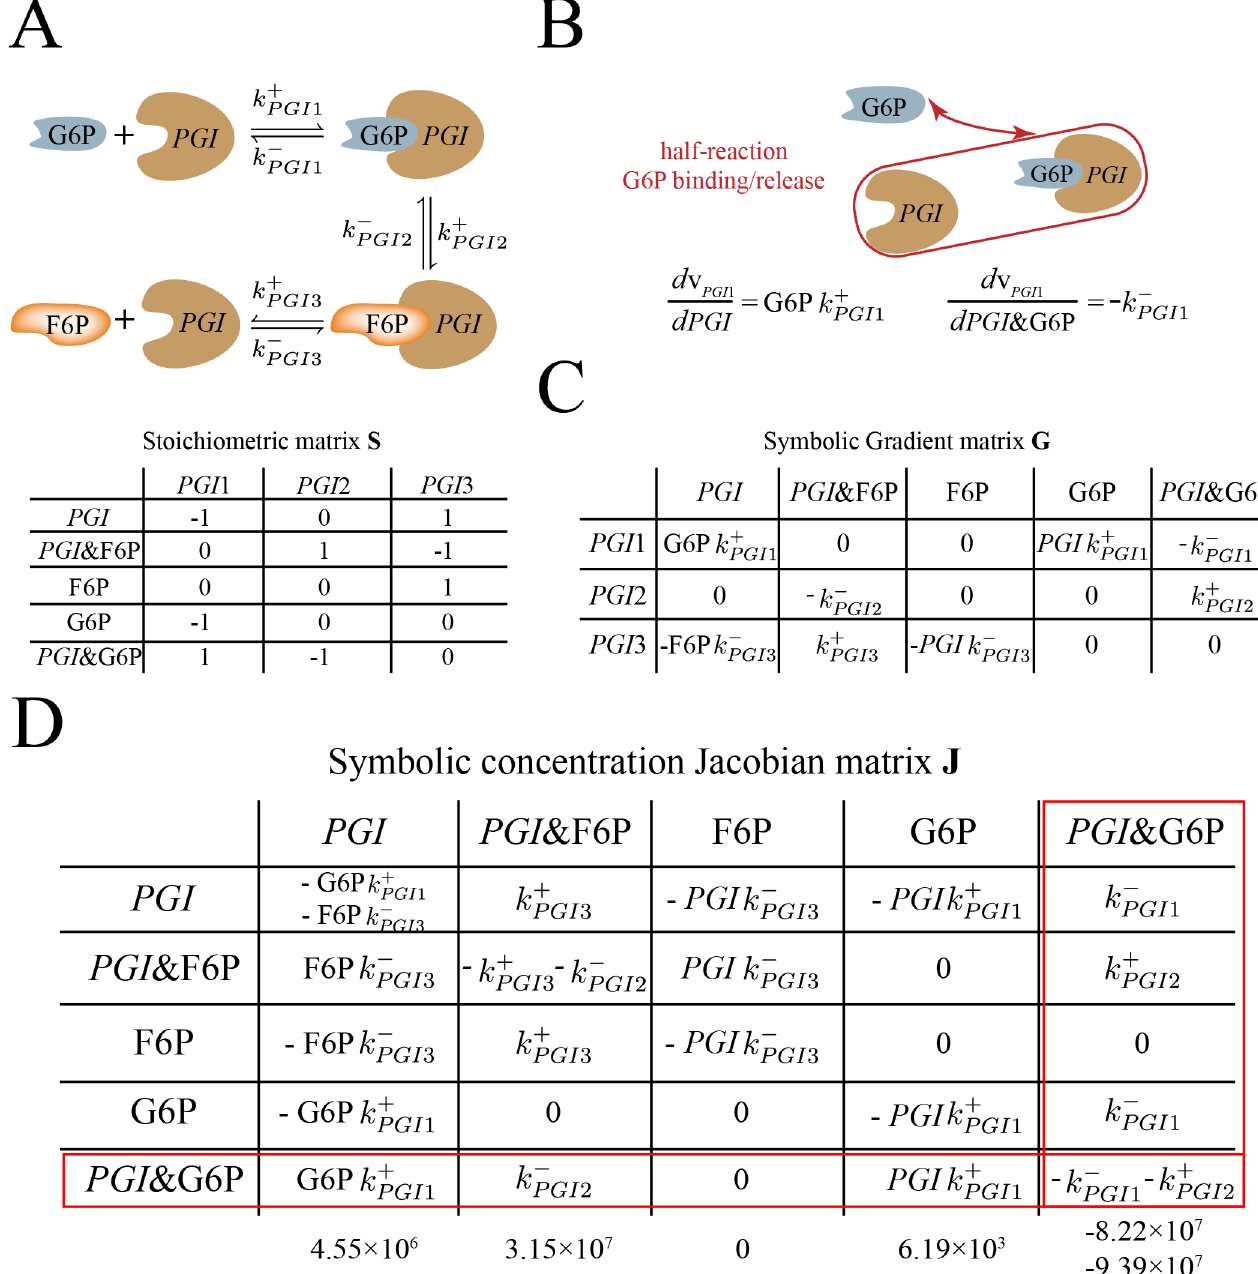
Fig 1. PGI enzyme module and its associatedmatrices. (A) A schematic diagram of individual reaction steps associatedwith PGI enzyme module and its stoichiometric matrix. The PGI enzyme module consists of three reactionsteps: bindingof G6P ( PGI 1), conversionof G6P to F6P ( PGI 2) and releaseof F6P ( PGI 3). The enzyme form PGI is in italic. We use an “&” notation to denote that the enzyme form is bound with metabolite (s). (B) Graphicalrepresentation of the concept of half reaction. Here we demonstrate the half reaction associatedwith the binding/release process of G6P, which is held constant. To determinethe equilibriumstate of this half reaction, we are comparing the sensitivitiesassociatedwith PGI (G6P k + PGI 1 ) and PGI &G6P (- k - PGI 1 ). This comparisonis equivalentto comparing G6P concentration and 1/K eq , PGI 1 . (C) The gradientmatrix of the PGI enzyme module.The gradientmatrix (= d v / d x )is obtainedfrom linearization of the reaction rates and representsreaction sensitivitiesto metaboliteconcentrations. (D) The cause of diagonaldominancedemonstrated through the symbolic concentration Jacobianmatrix of the PGI enzyme module.Using row 5 as a case study, we observethat, in the case of mass action rate law, diagonaldominanceis determined by the distancefrom half-reaction equilibriumfor individualhalf-reactions. When comparing the terms associated with PGI 1 reactionbetween diagonal and off-diagonalpositions,we are comparing the sensitivity of G6P ( PGIk + PGI 1 ) and sensitivity of PGI (G6P k + PGI 1 ) with that of PGI &G6P (- k - PGI 1 ). This comparisonis equivalent to comparing the concentrations of PGI and G6P with K d, PGI 1 (K d, PGI 1 = k - PGI 1 / k + PGI 1 ), thus determiningthe distancefrom